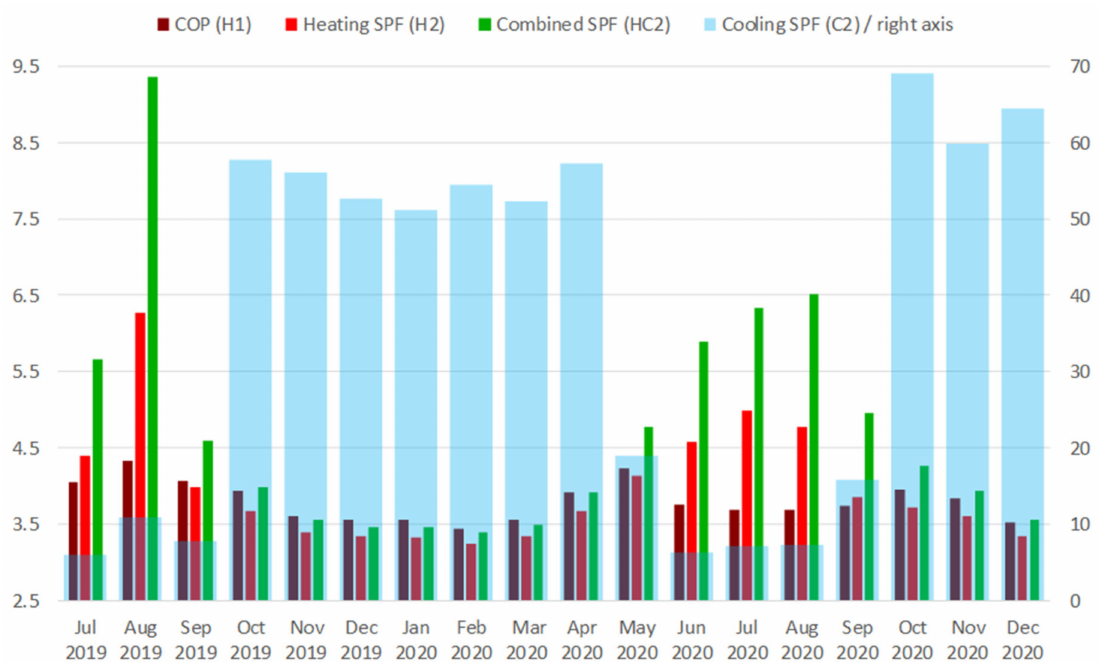
Figure 10. Heat Pump (HP) performance: Coefficient of Performance (COP), heating (Seasonal Performance Factor (SPF) H2), cooling (SPF C2), and combined (SPF